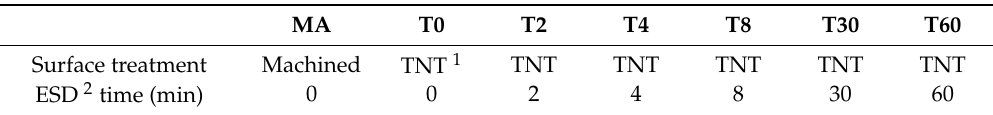
Figure 1. Schematic drawings of the ( a ) electrochemical anodization and ( b ) electrospray deposition system. Table 1. Surface properties of